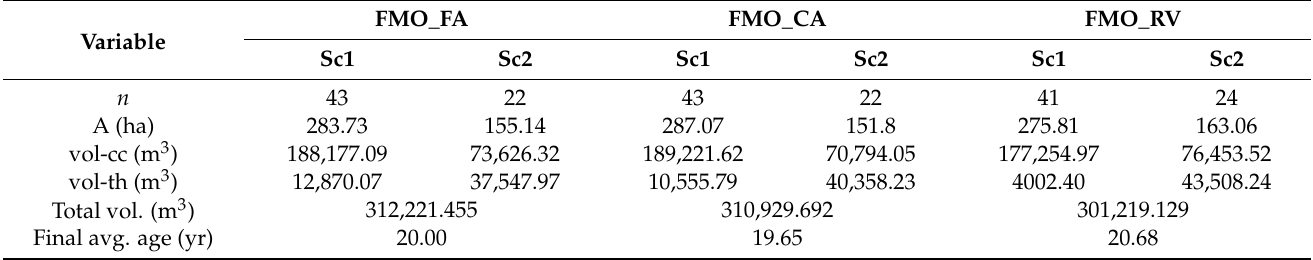
Table A1. Characterization of FMO_CA, FMO_CA, and FMO_CA results according to the optimal solution, discriminated by scenario.